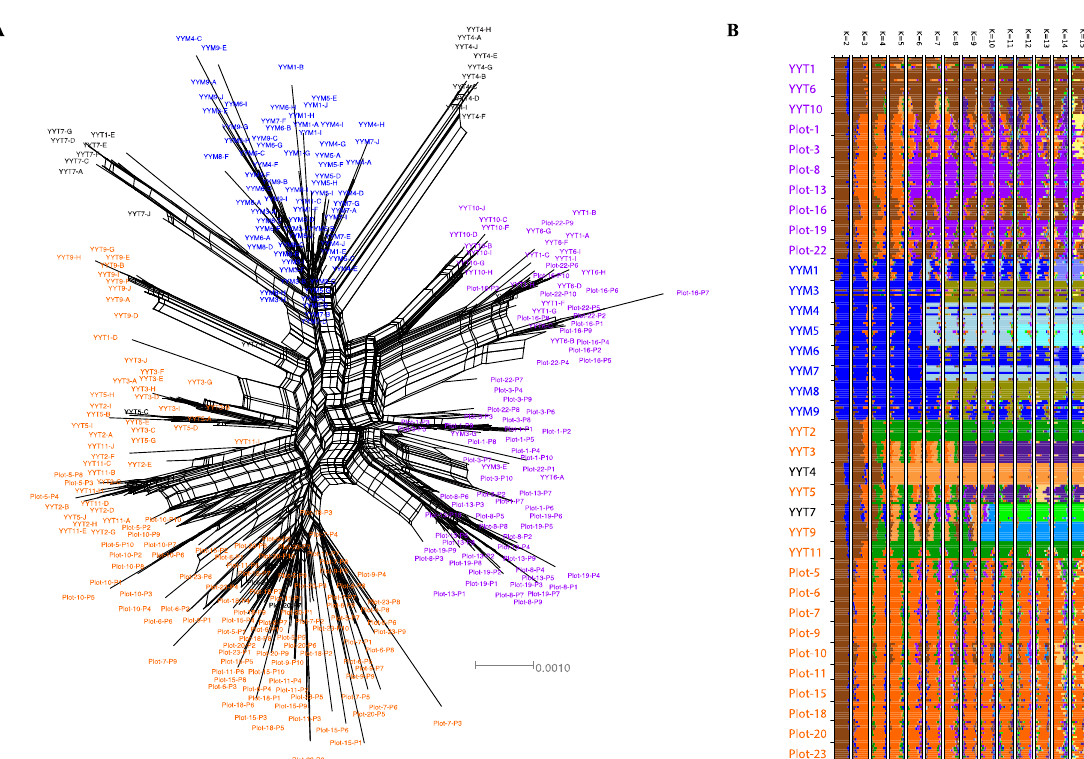
Figure 1. ( A ) Neighbor-Net split decomposition network indicating the relationships between rice accessions based on 12,112 analyzed SNPs. Plant samples assigned to the HY, MH and TIL indica variety groups are labelled in purple, blue and orange, respectively. Plant samples that were not assigned to one of the three variety groups (“outlier varieties”) are labelled in black. Characters A to J or P1 to P10 (e.g., YYT5-J or Plot-23-P2) refer to individual plants that were collected from each rice field (7–10 plants were collected in each field, Table 1) ( B ) Ancestry proportions within accessions for sNMF models [26] from K = 2 to K = 15 ancestral populations. Each horizontal bar represents the proportion of ancestry within a single accession, with colors corresponding to ancestral populations.